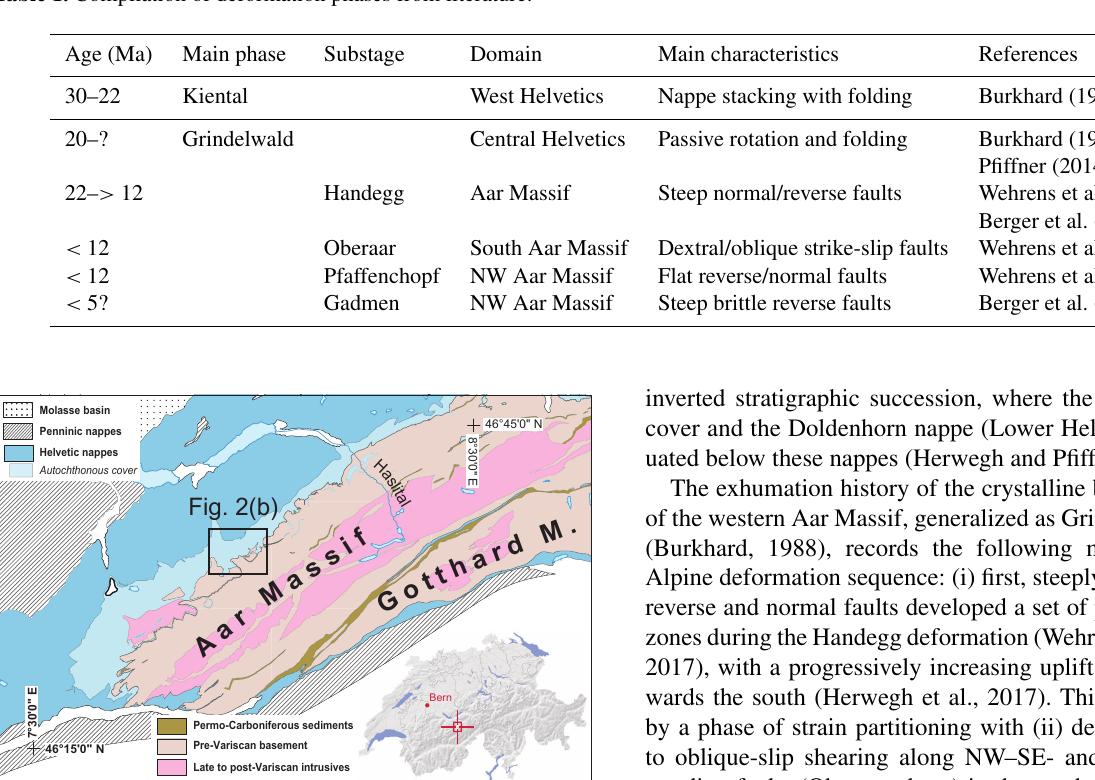
Table 1. Compilation of deformation phases from literature.